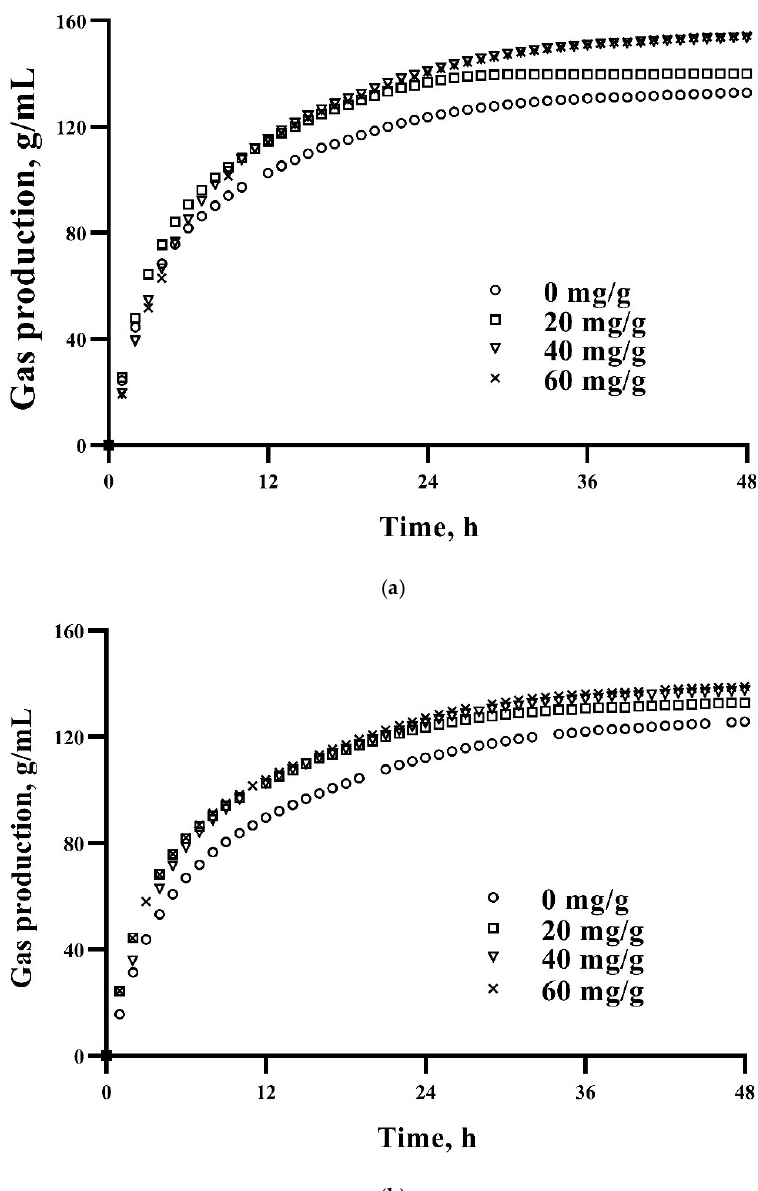
Figure 1. Cumulative gas production profiles of in vitro fermentation of substrates with LF ( a ) and HF ( b ) in response to increasing CS supplementation in culture fluids at 48 h.